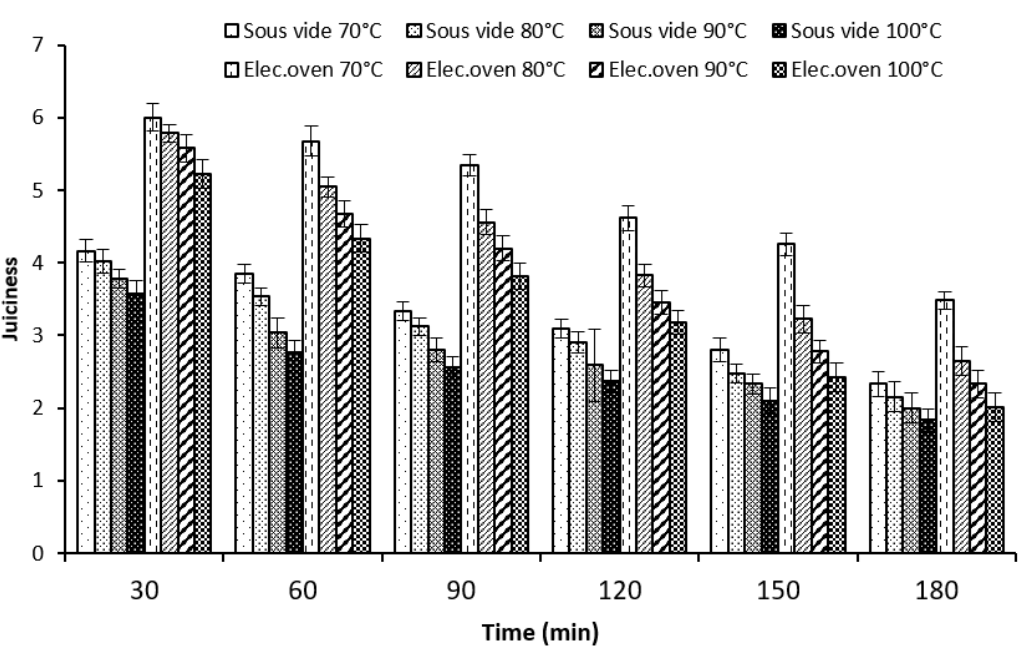
Figure 9. The effect of the cooking method (sous vide vs. electrical oven) on the camel meat sensory properties (flavor) at different combinations of temperature and time.